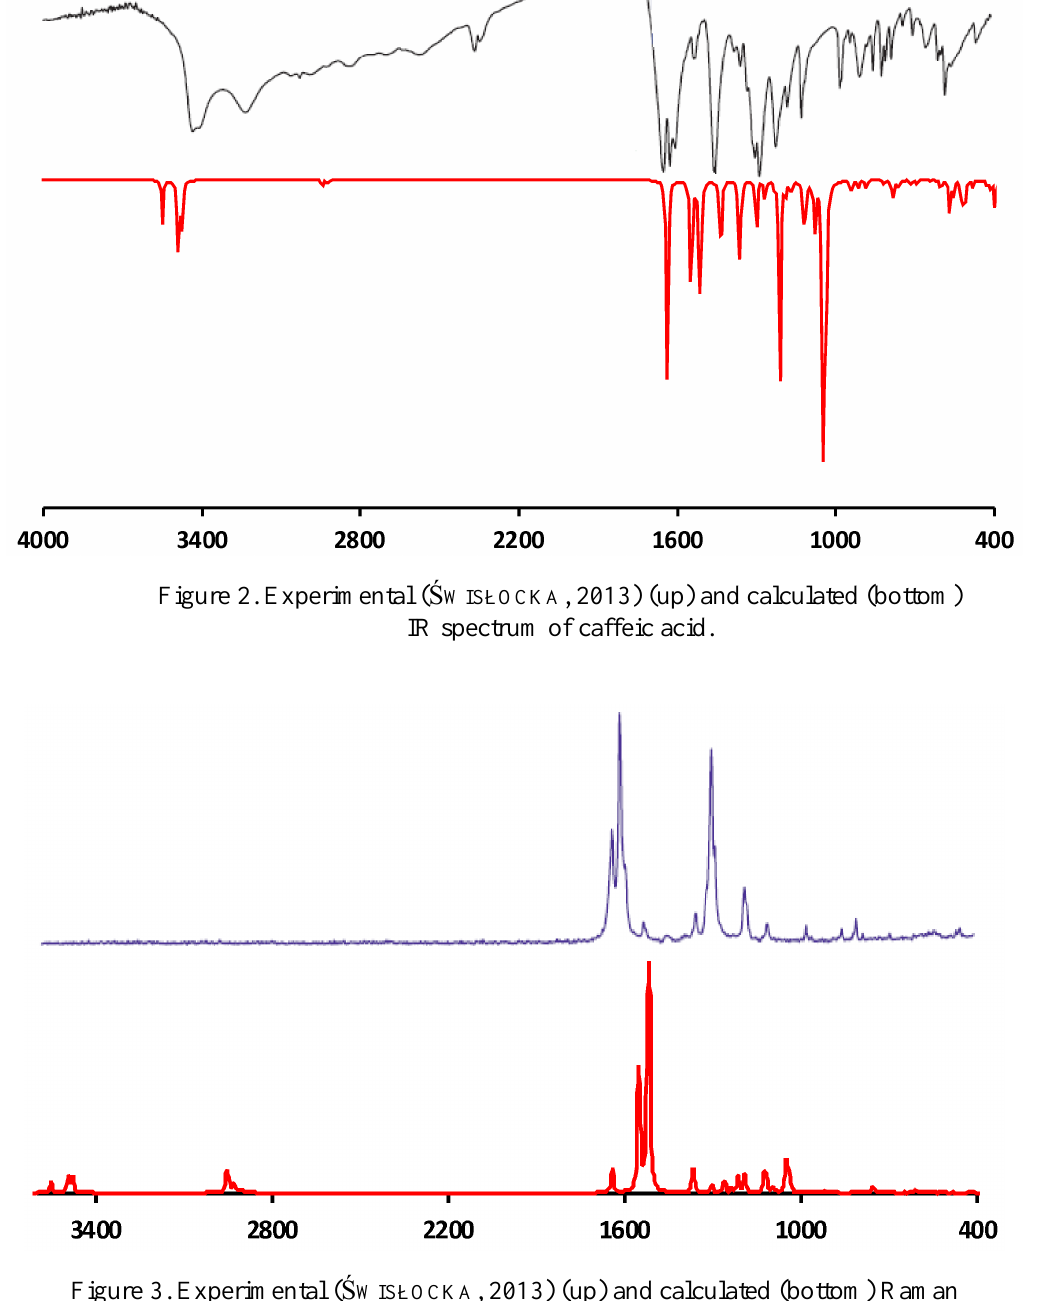
Figure 3. Experimental ( Ś WISŁOCKA , 2013) (up) and calculated (bottom) Raman spectrum of caffeic